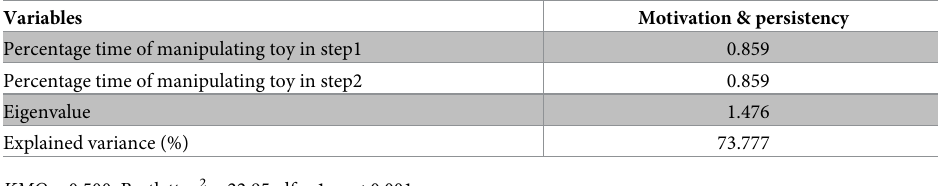
Table 11. Components derived from PCA on the variables measured in the manipulative persistency subtest.